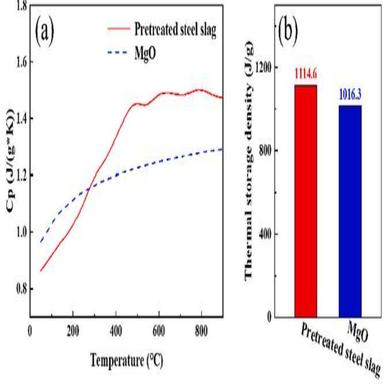
(a) Specific heat and (b) thermal storage density in the temperature range of 50 ◦C–900 ◦C of pretreated steel slag and MgO.